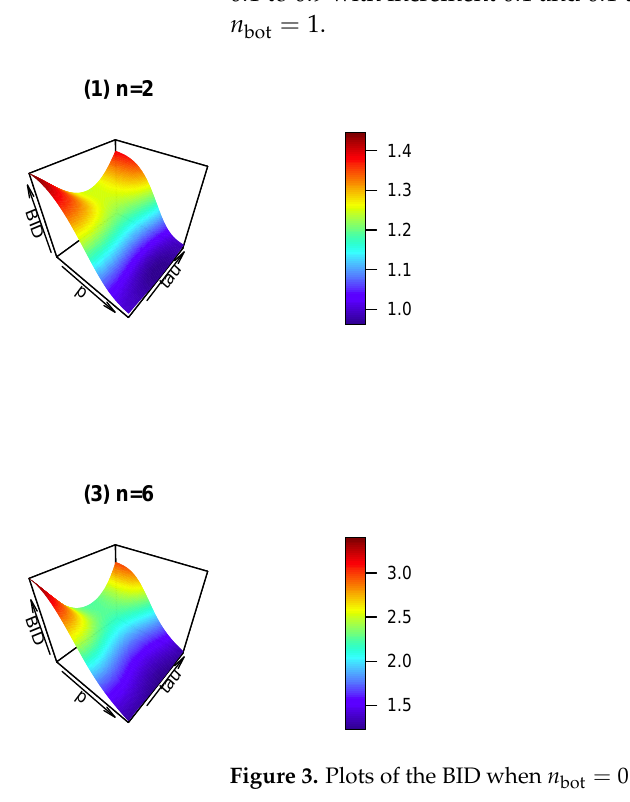
Figure 3. Plots of the BID when n bot = 0.